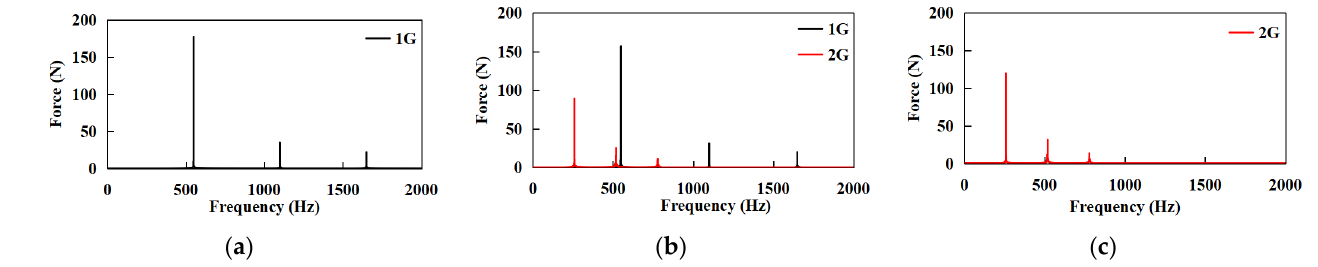
Figure 10. Axial dynamic meshing force spectrum: ( a ) input shaft spectrum; ( b ) intermediate shaft spectrum; ( c ) output shaft spectrum.